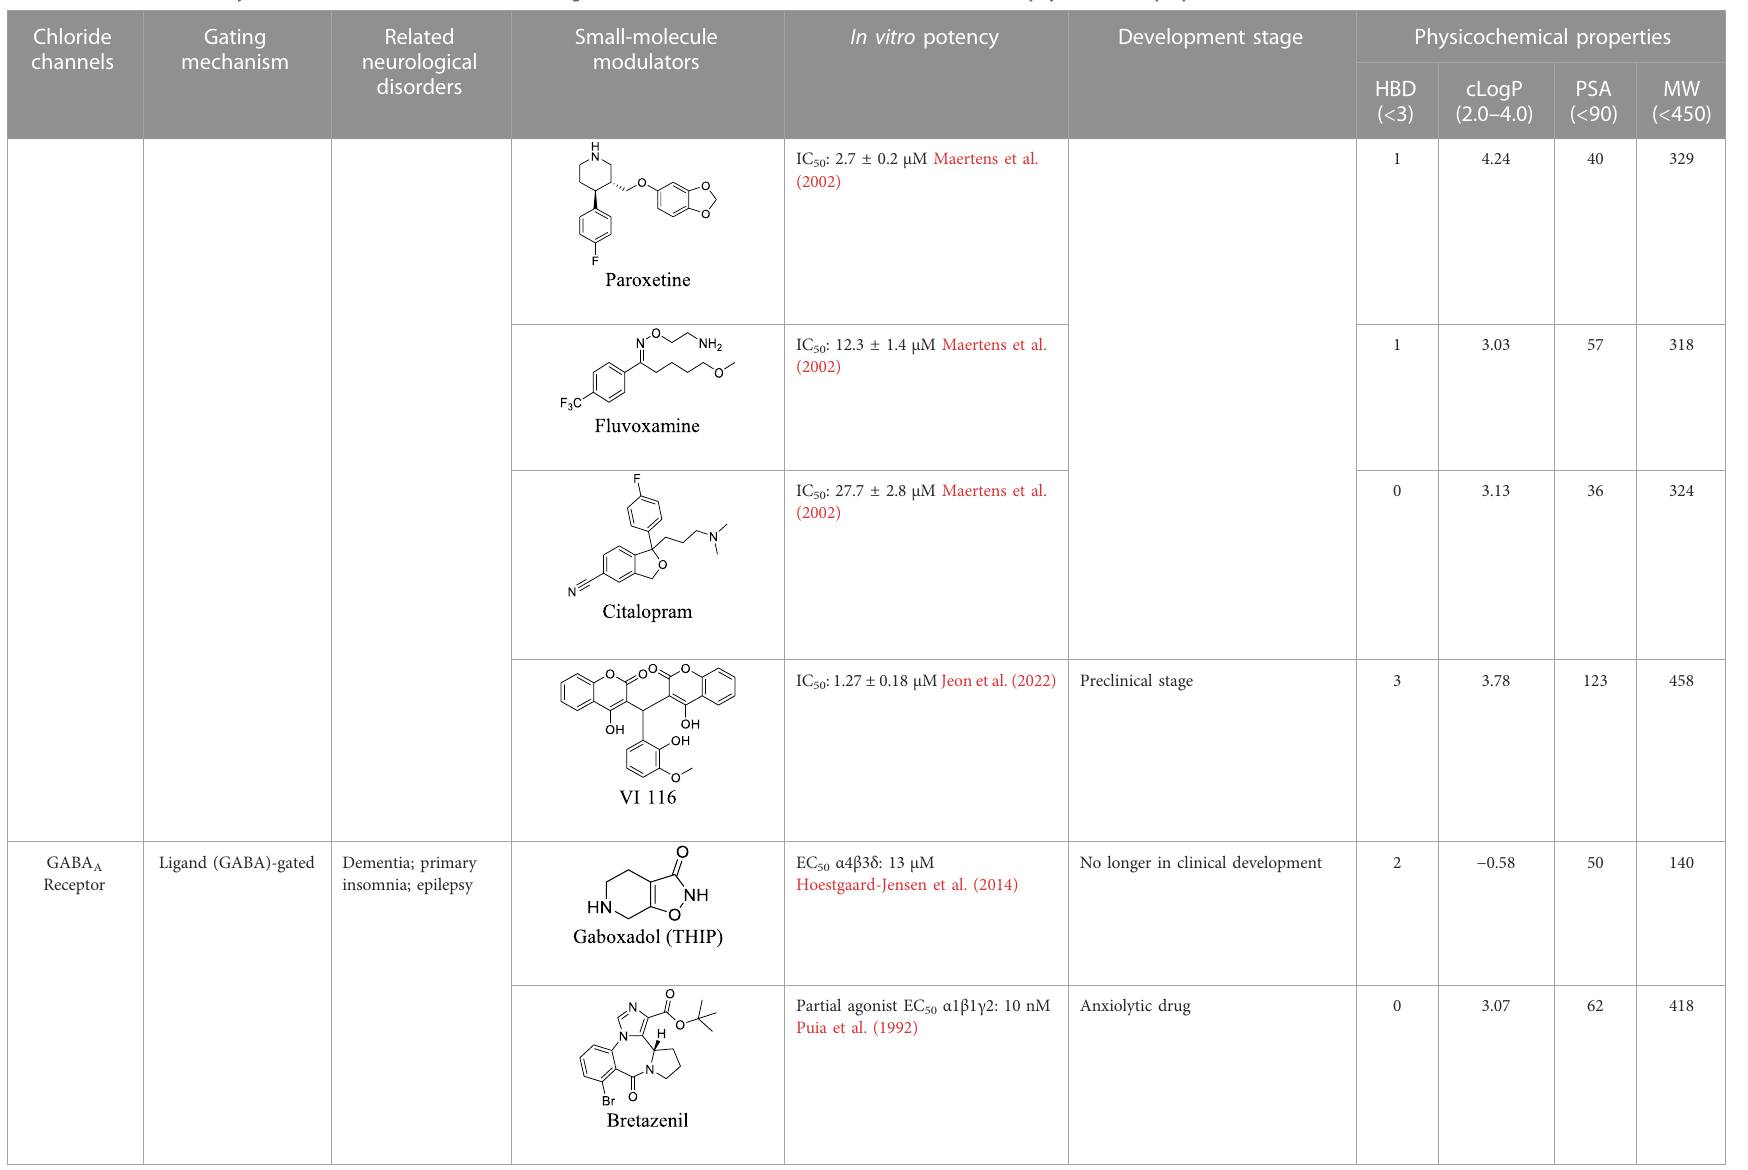
TABLE 1 ( Continued ) Summary of chloride channels involved in neurological disorders and their small-molecule modulators with physiochemical